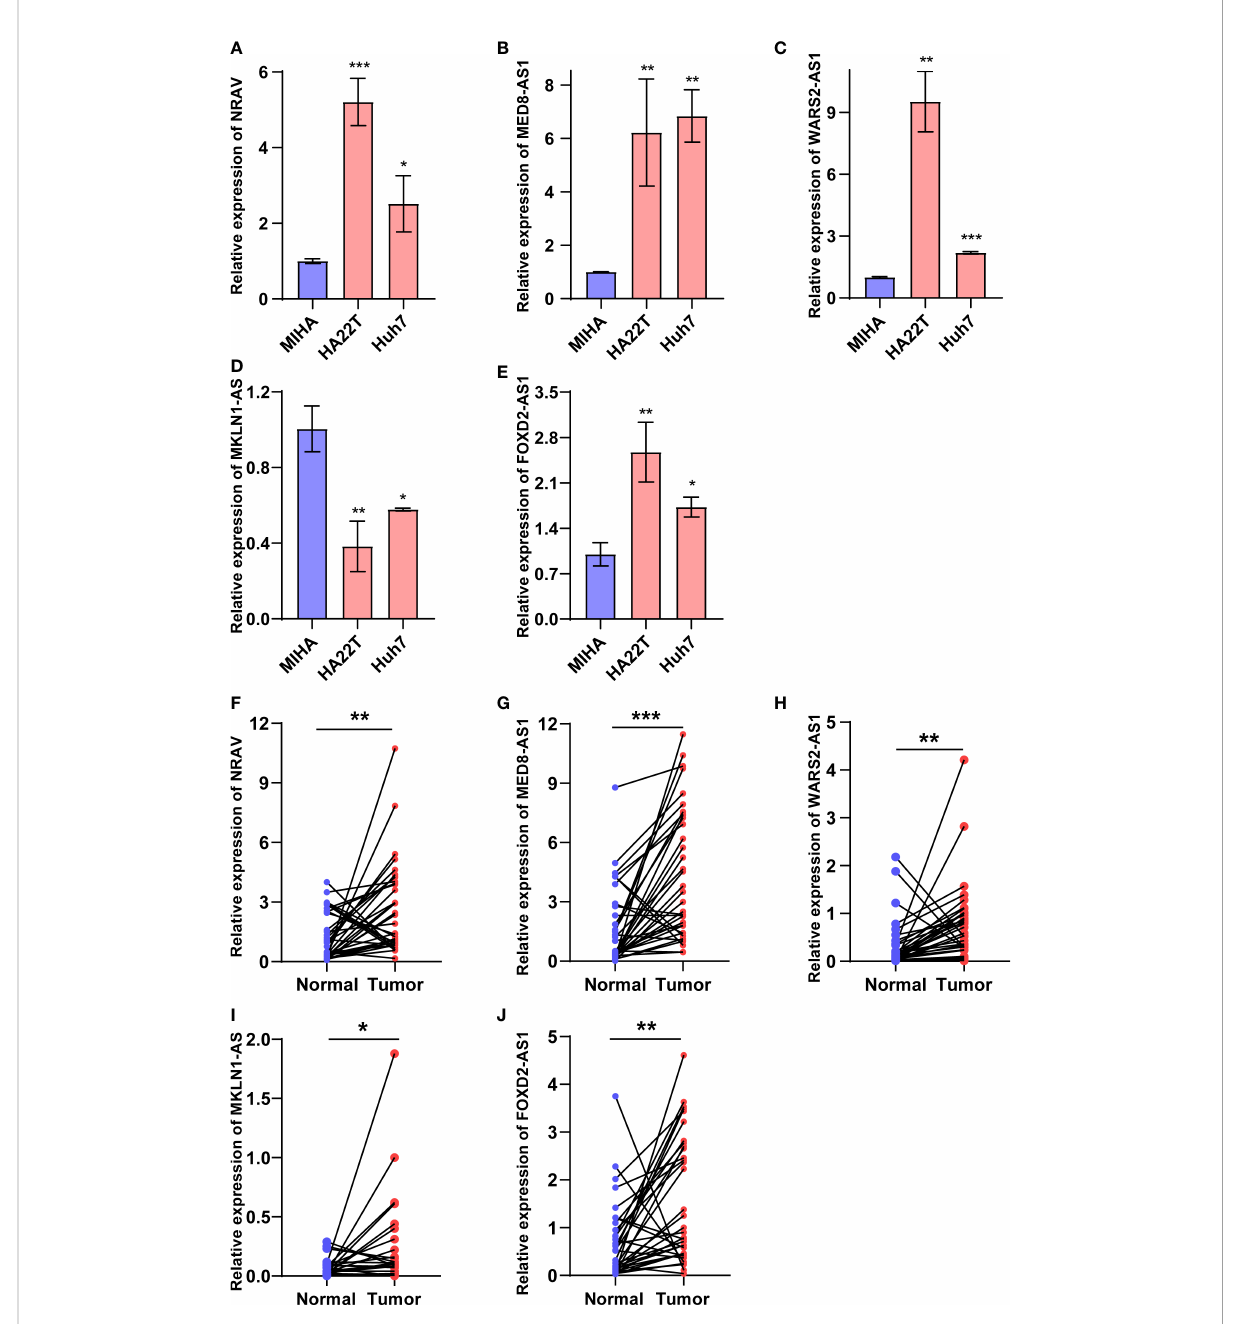
FIGURE 9 Validation of fi ve cuproptosis-related lncRNAs expressions in HCC cell and tissues. (A-E) FOXD2-AS1, NRAV, MED8-AS1, WARS2-AS1 and MKLN1-AS expression in normal liver cells and HCC cells. (F-J) FOXD2-AS1, NRAV, MED8-AS1, WARS2-AS1 and MKLN1-AS expression in HCC tissues and adjacent normal tissues. *p < 0.05, **p < 0.01, and ***p <